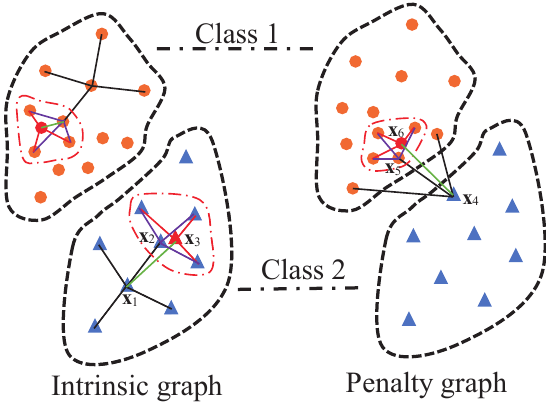
Figure 2. Graph construction of the LGSFA